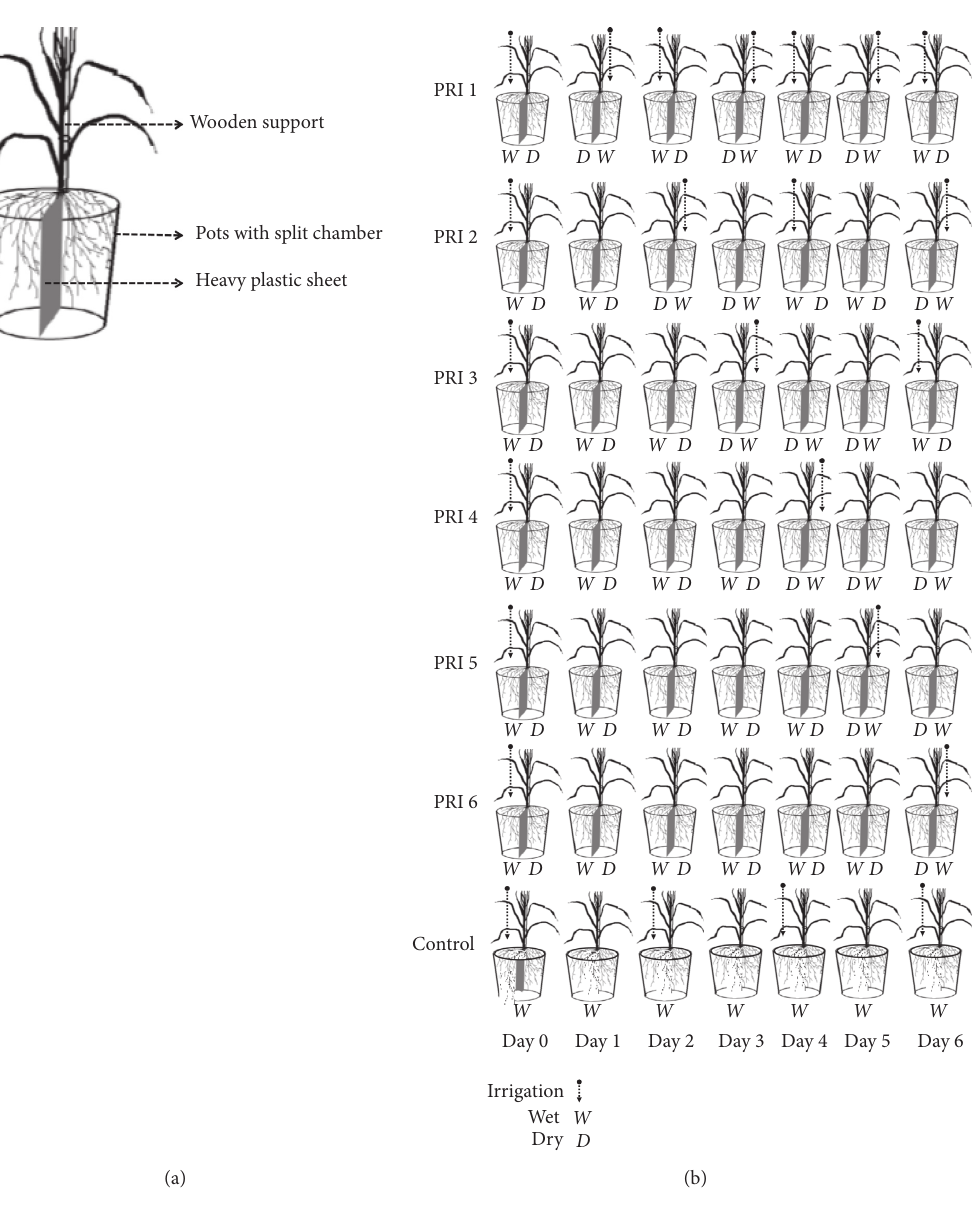
Figure 1: Schematic view of the split root pot (a) and irrigation treatments (b) in